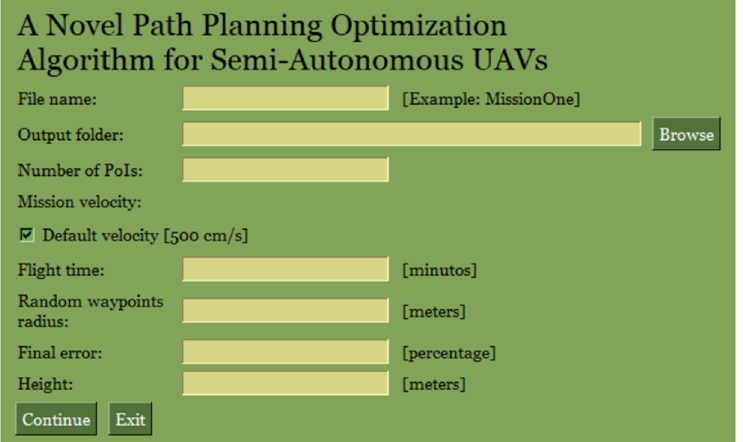
Figure 4. First window of the path planning optimization algorithm GUI.